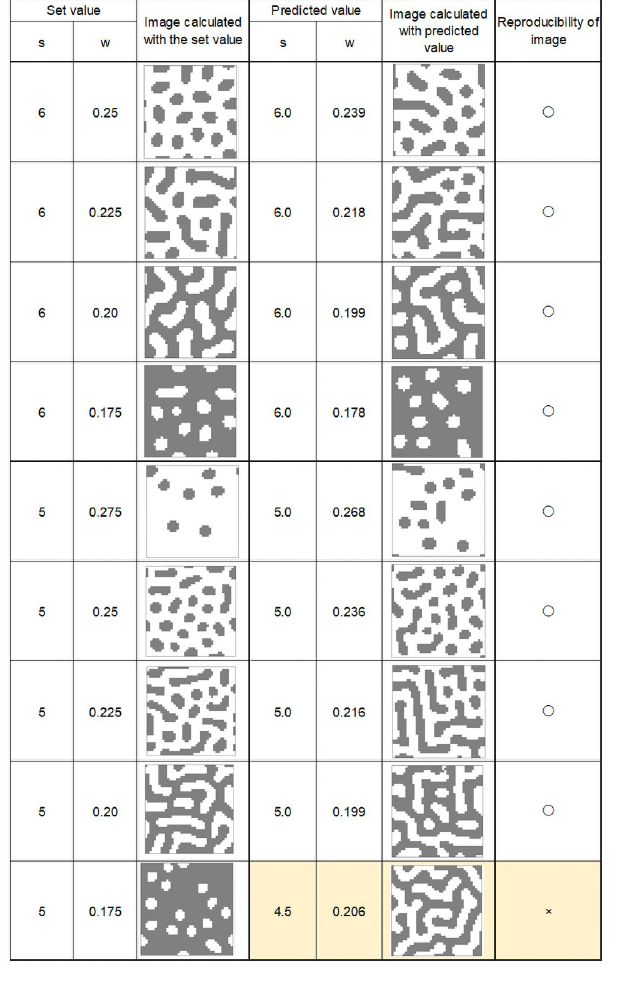
Fig 9. Calculation results